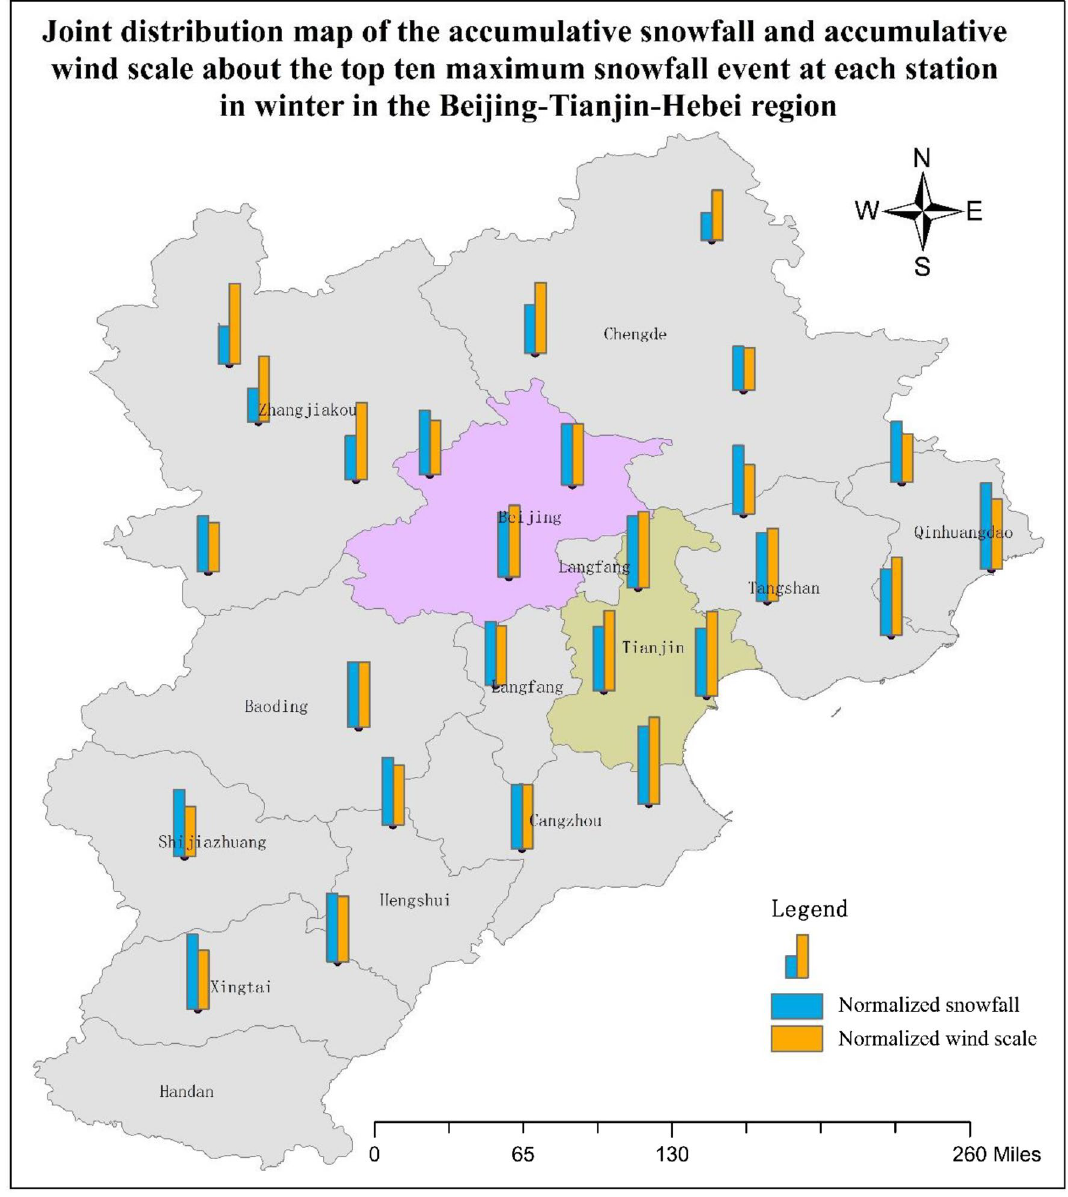
Figure 6. Joint distribution map of the accumulative snowfall and accumulative wind scale from the top ten maximum snowfall events at each station in the Beijing–Tianjin–Hebei region. The present map was done by using ArcGIS 10.0 desktop version (https ://www.esri.com/zh-cn/arcgi s/produ cts/arcgi s-pro/overv